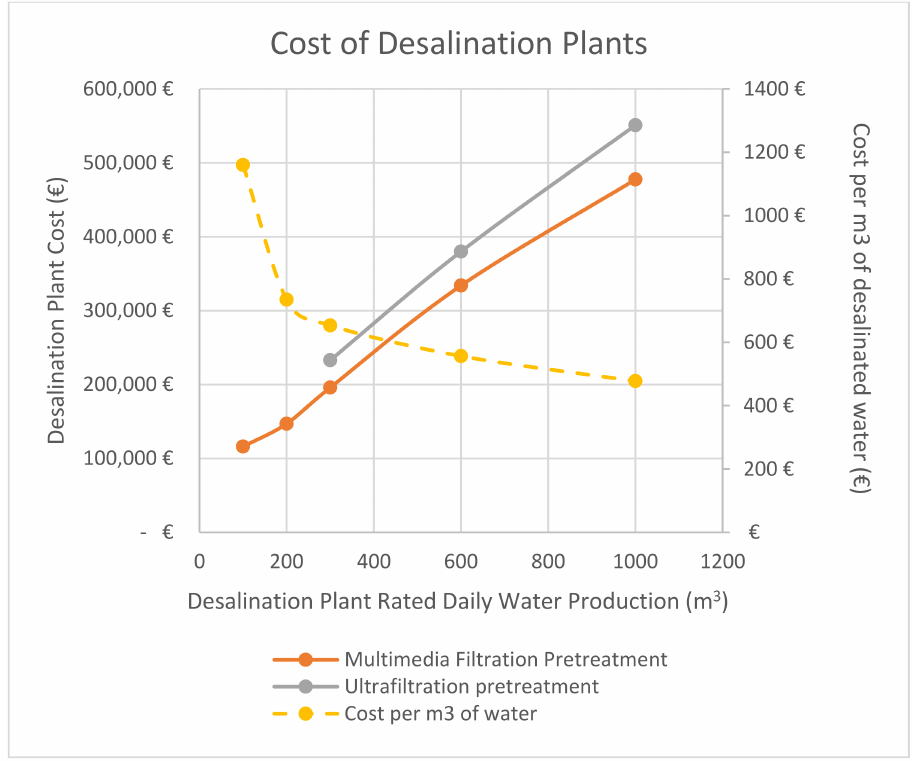
Figure 3. Desalination plant cost (Source: Personal communication with Orfeas Mavrikios—CEO of Watera Hellas, Athens,